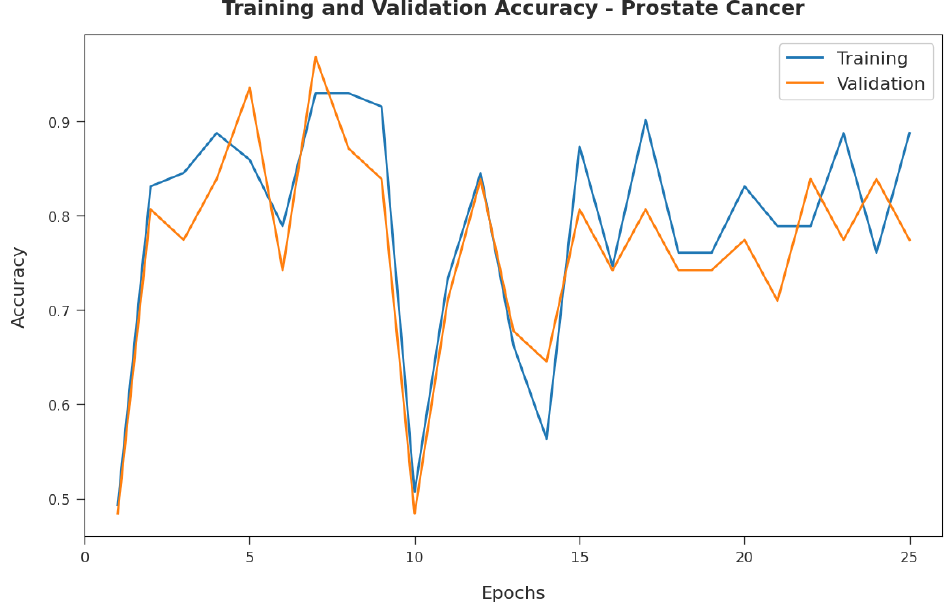
Figure 4. Accuracy analysis of RFODL-MGEC technique on prostate cancer dataset. Figure 5 exemplifies the training and validation loss inspection of the RFODL-MGEC model with the prostate cancer dataset. Figure 5 shows that the RFODL-MGEC model offered reduced training/accuracy loss for the classification process of the test